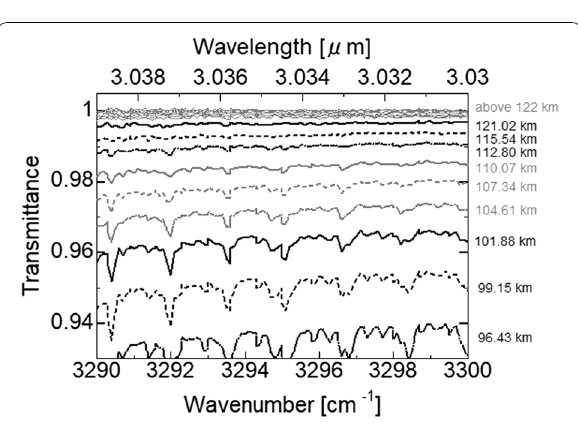
Fig. 2 Example of observed transmittances (Dec. 03, 2007, order 147, orbit 591, latitude 9 ◦ S , longitude 209 ◦ ) above an altitude of 95 km. These wavelengths are selected to visualize the observed spectra. The observed transmittances above 122 km are almost unity, because the solar light is not yet being absorbed by the atmosphere. At altitudes lower than 122 km, the standard deviation on the observed transmittance is small enough to isolate an individual observed